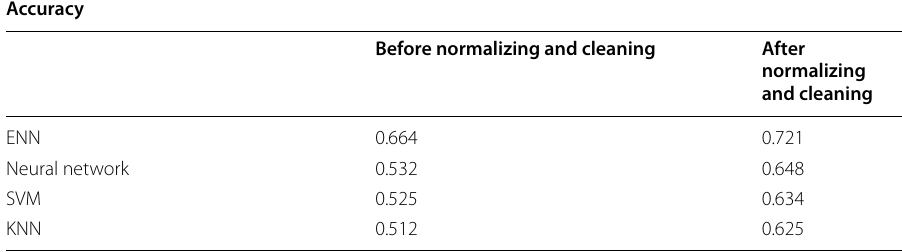
Table 3 F1-scores of models before and after normalizing and cleaning phase Accuracy